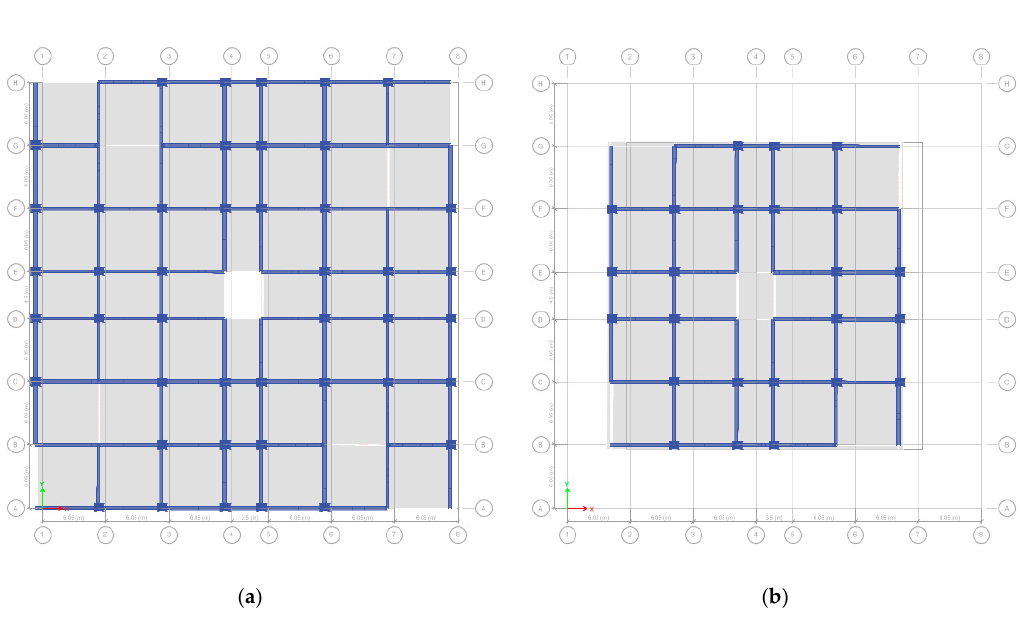
( b ) Figure 18. The 2nd mode shape for T 2 = 0.512 s: ( a ) plane view of the 1st floor, and ( b ) plane view of the 10th floor. In Figure 19, the spatial behaviour of the structure is presented. One can see that by using the additional elements, torsion can be prevented.